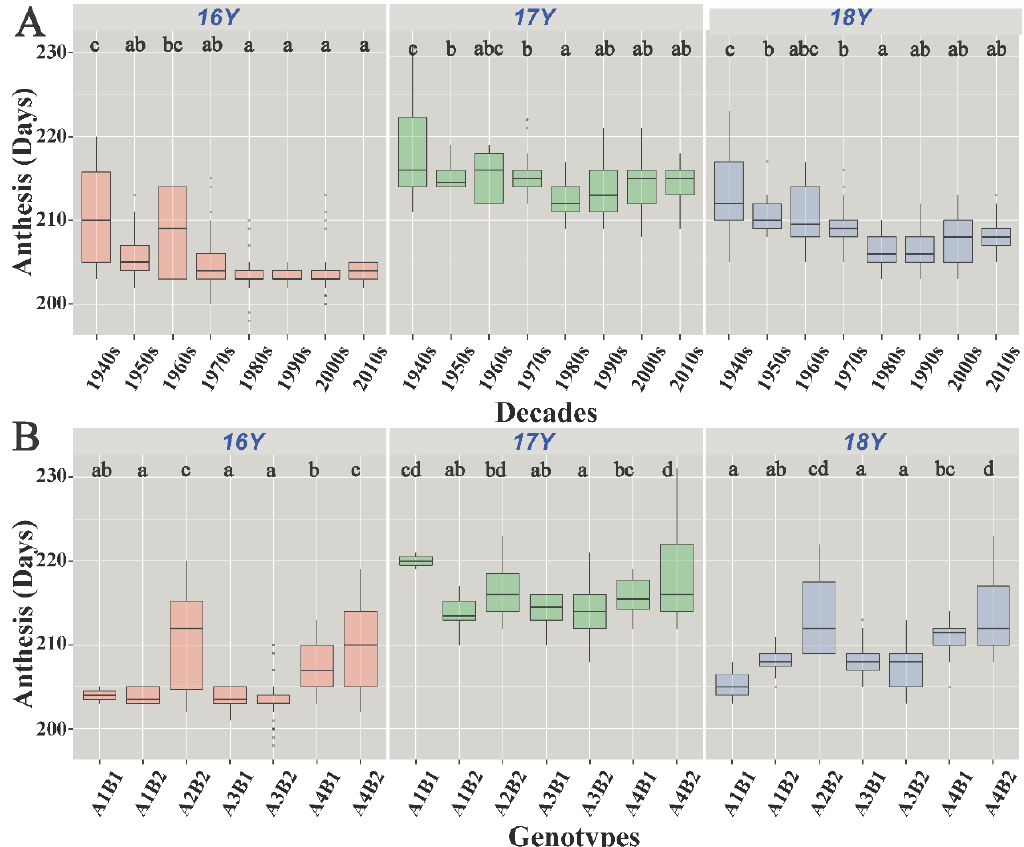
Figure 5. Boxplot of anthesis: ( A ) boxplot of anthesis of varieties of different eras; ( B ) boxplot of different genotypes affecting anthesis. 16Y, the 2016–2017 growing season; 17Y, the 2017–2018 growing season; 18Y, the 2018–2019 growing season. The different letters indicate significance at the 0.05 level.